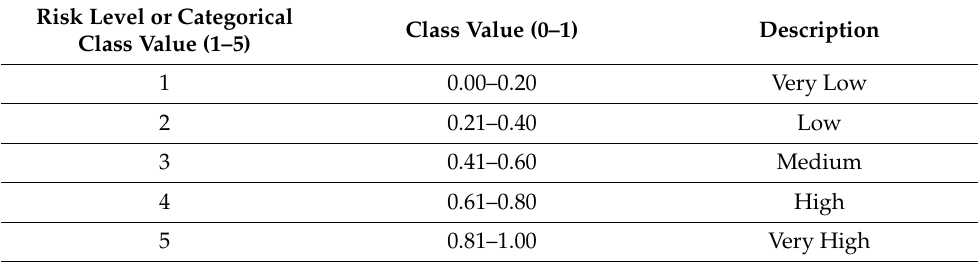
Table 2. Risk categorical class values by GIZ, EURAC and UNU-EHS (2018) [23]. Risk Level or